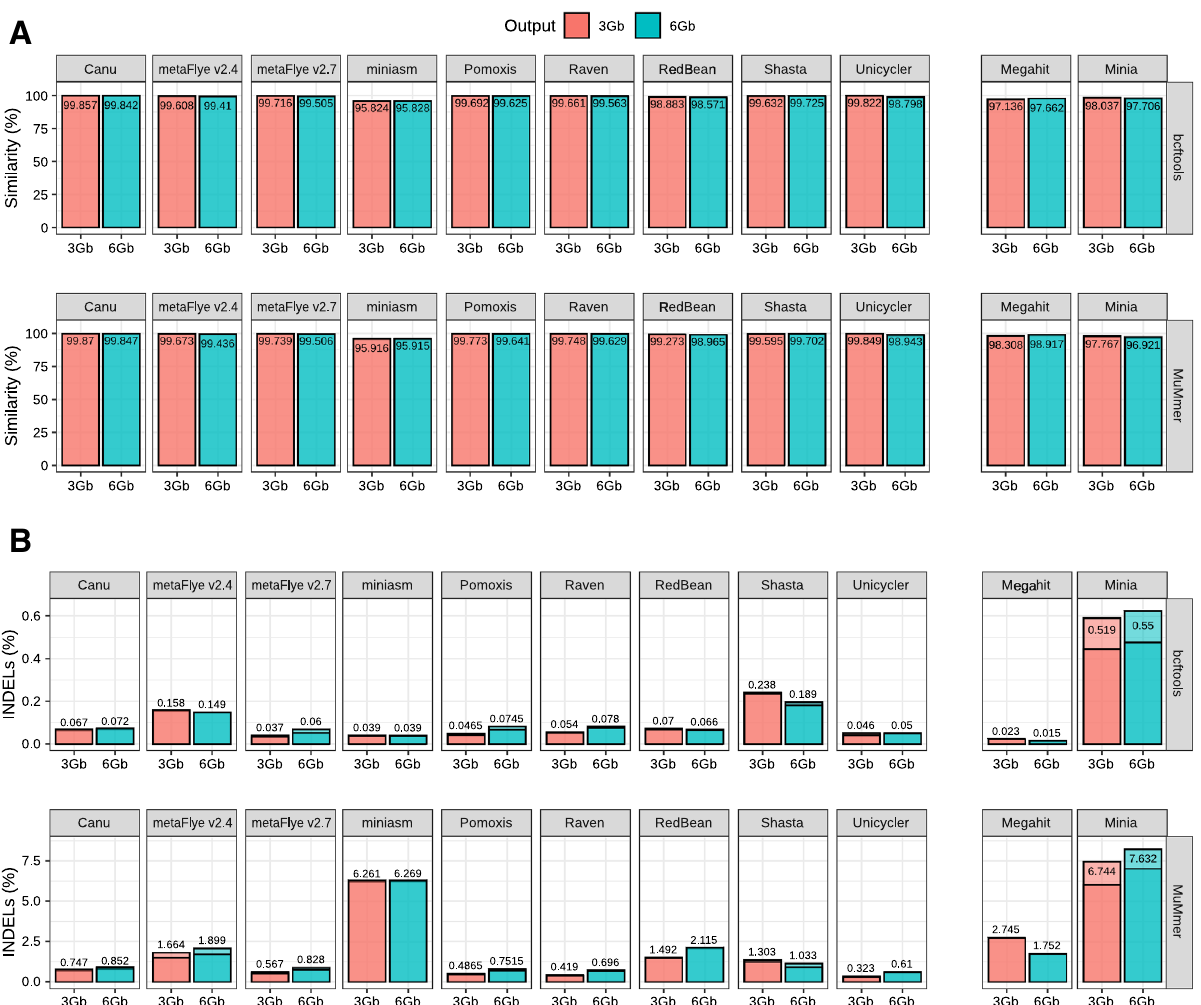
Figure 5. Assembly accuracy for the draft assemblies (subsampled Even datasets). ( A ) Percentage of similarity calculated as the total number of matches normalized by the metagenome size; ( B ) percentage of indels calculated as the total number of indels normalized by the metagenome size. In both cases, two different strategies were used: (top panel) alignment with minimap and evaluation with bcftools + ‘indels_and_snps.py’ in-house script; (bottom panel) alignment with MuMMer and evaluation with ‘count_SNPS_indels.pl’ script from Goldstein et al. 9